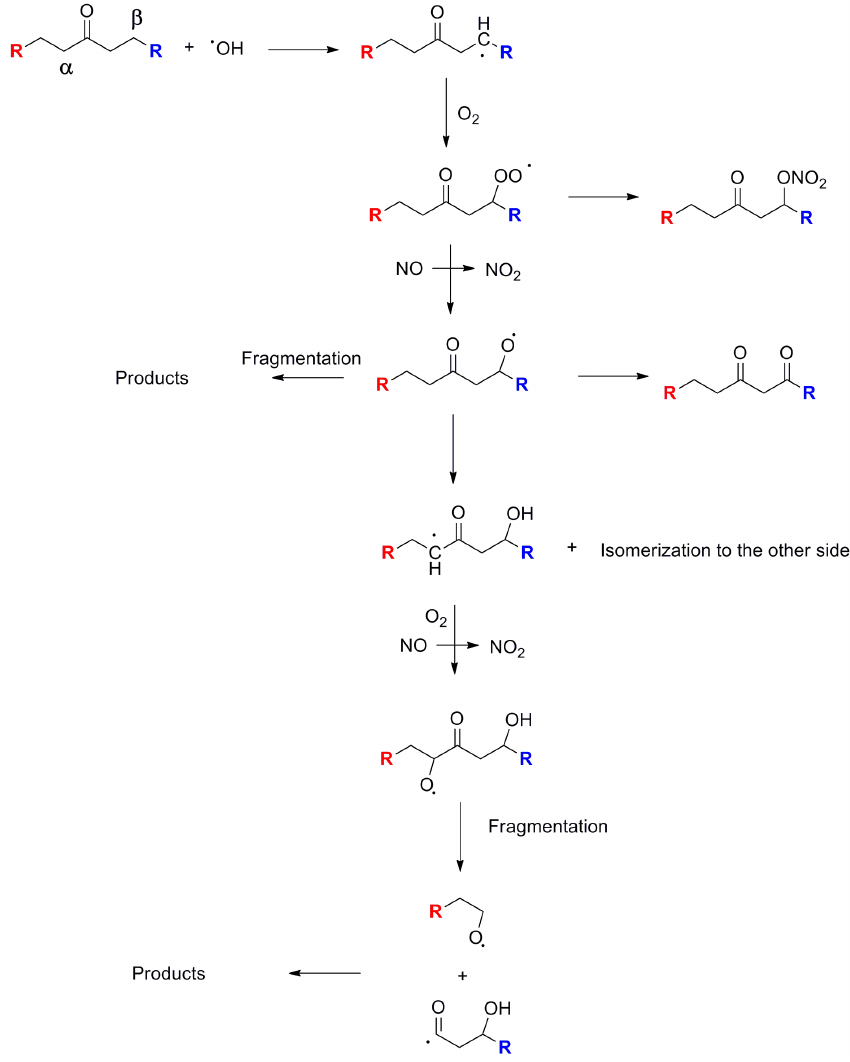
Fig. 7. A partial high-NO x OH-radical oxidation mechanism of 7-tridecanone, emphasizing the OH radical attack of the β-hydrogens. Figure G in the supplementary information shows evidence of n- hexanal formation from the 5 OH radical oxidation of 7-tridecanone at high NO x . 6